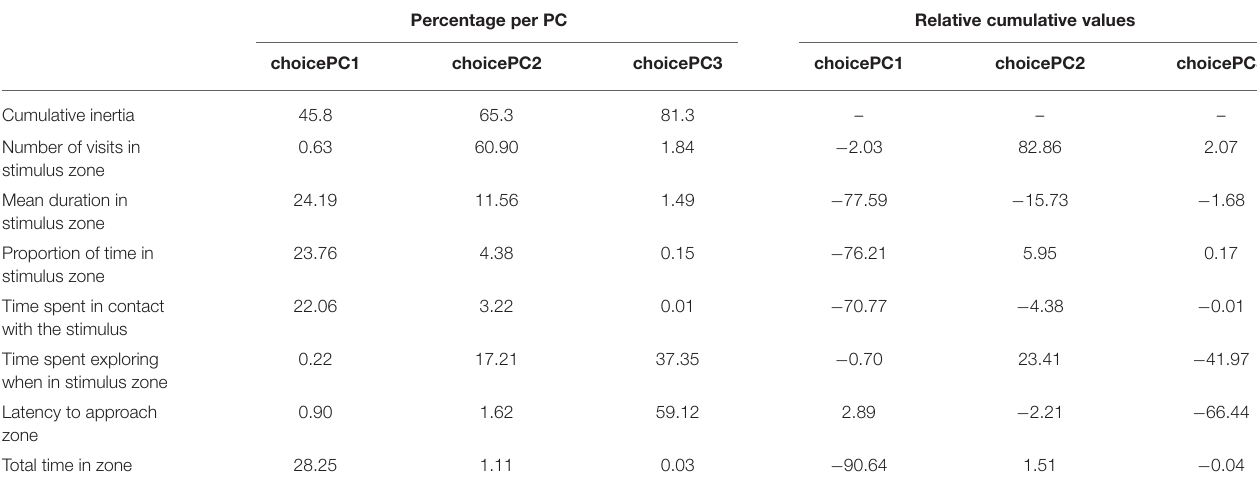
TABLE 2 | Variable loadings of the behavioral parameters used in the Principal Component Analysis in the Choice